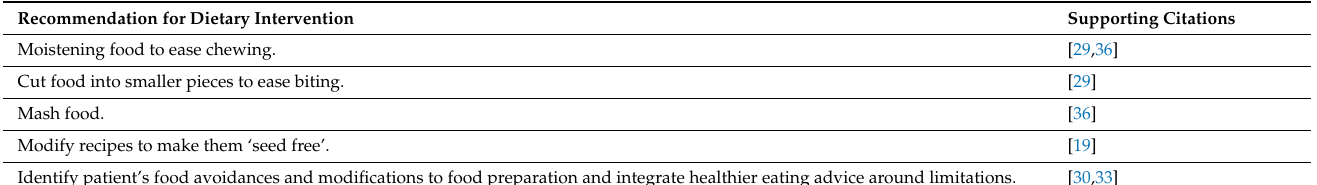
Table 2. Summary of recommendations for dietary intervention in people who wear dentures, identified from the peer-reviewed